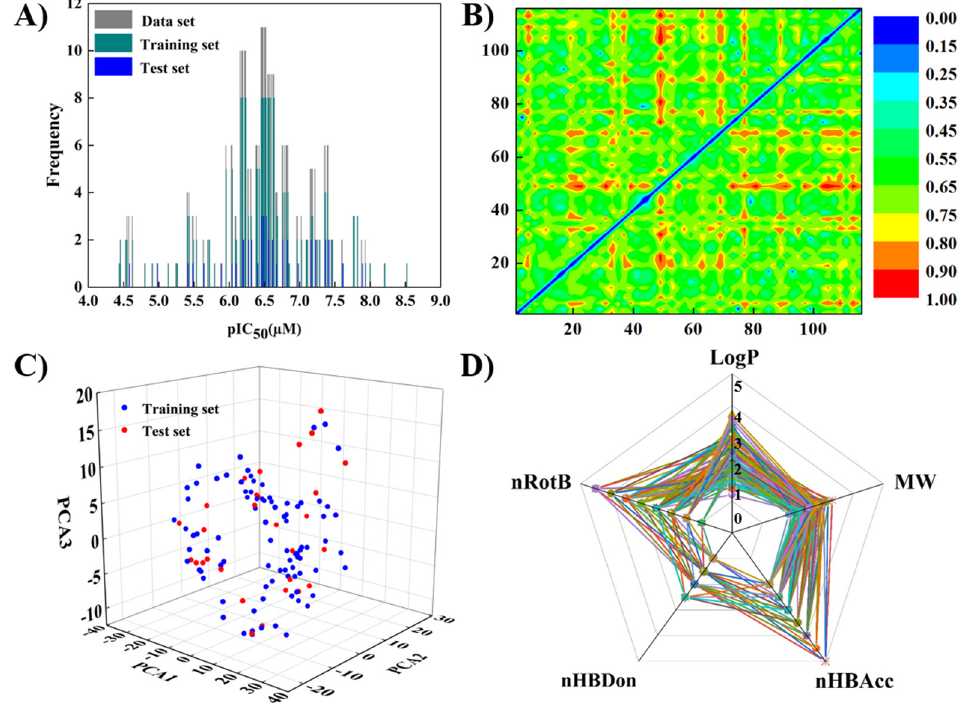
Figure 1. ( A ) Distributions of experimental pIC 50 values for the dataset ( 117, grey bars), training set (88, green bars), and test set (29, blue bars). ( B ) Heat map of the molecular similarity constructed by Euclidian distance metrics for the entire dataset. ( C ) Chemical space of the training set (blue dots) and test set (red dots) using top three principal components of dragon molecular descriptors (51% variance explained). ( D ) Radar map of the dataset with the parameters of Lipinski’s rules of five and the number of rotatable